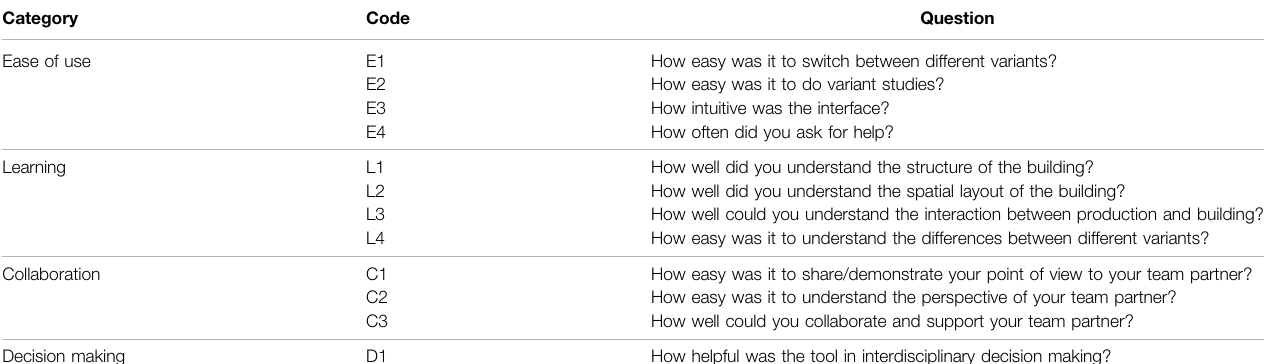
TABLE 1 | The questionnaire used in our pilot evaluation.